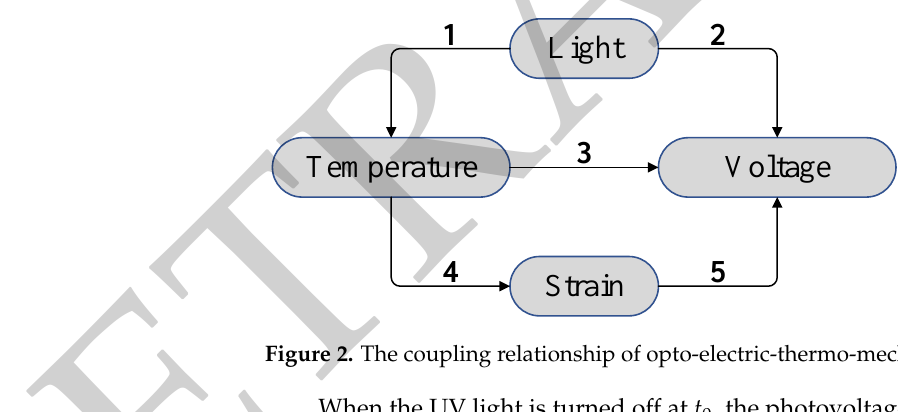
Figure 2. The coupling relationship of opto-electric-thermo-mechanic fields of PLZT